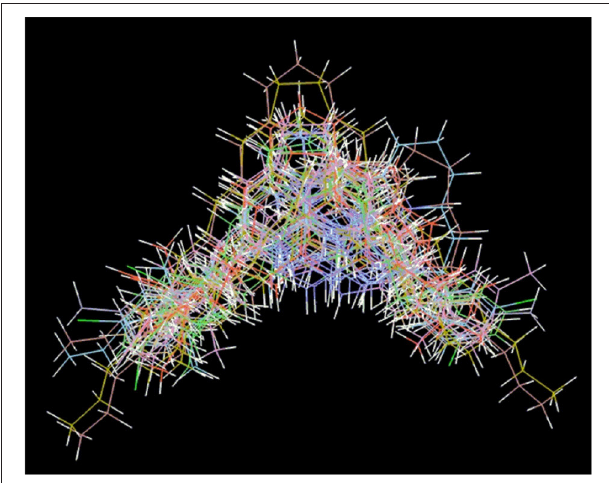
FIGURE 4 | 3D superimposed structures of compounds poses obtained from docking.